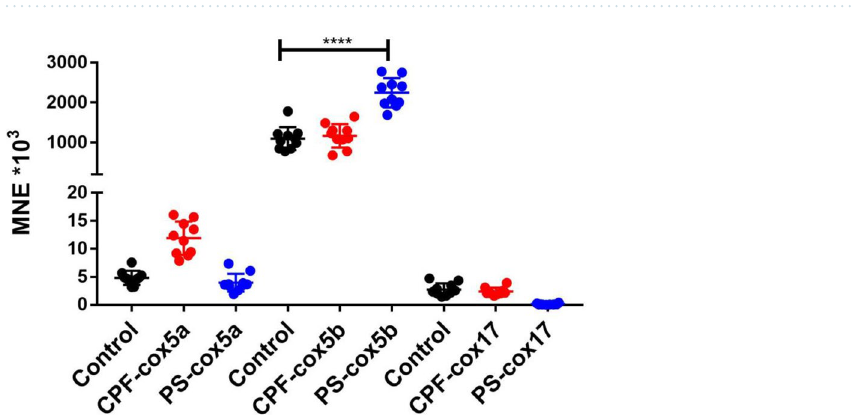
Figure 6. Abundance of transcripts of the oxidative phosphorylation ( cox5a , cox5b and cox17 ) in foragers of the same age after 24 h exposure to 0.6 ng/bee CPF and 2.65 microg/bee PS (black dots: controls, red dots: CPF, blue dots: PS, n = 10). Significant differences between controls and exposed foragers with p-value of ≤ 0.05 are marked with